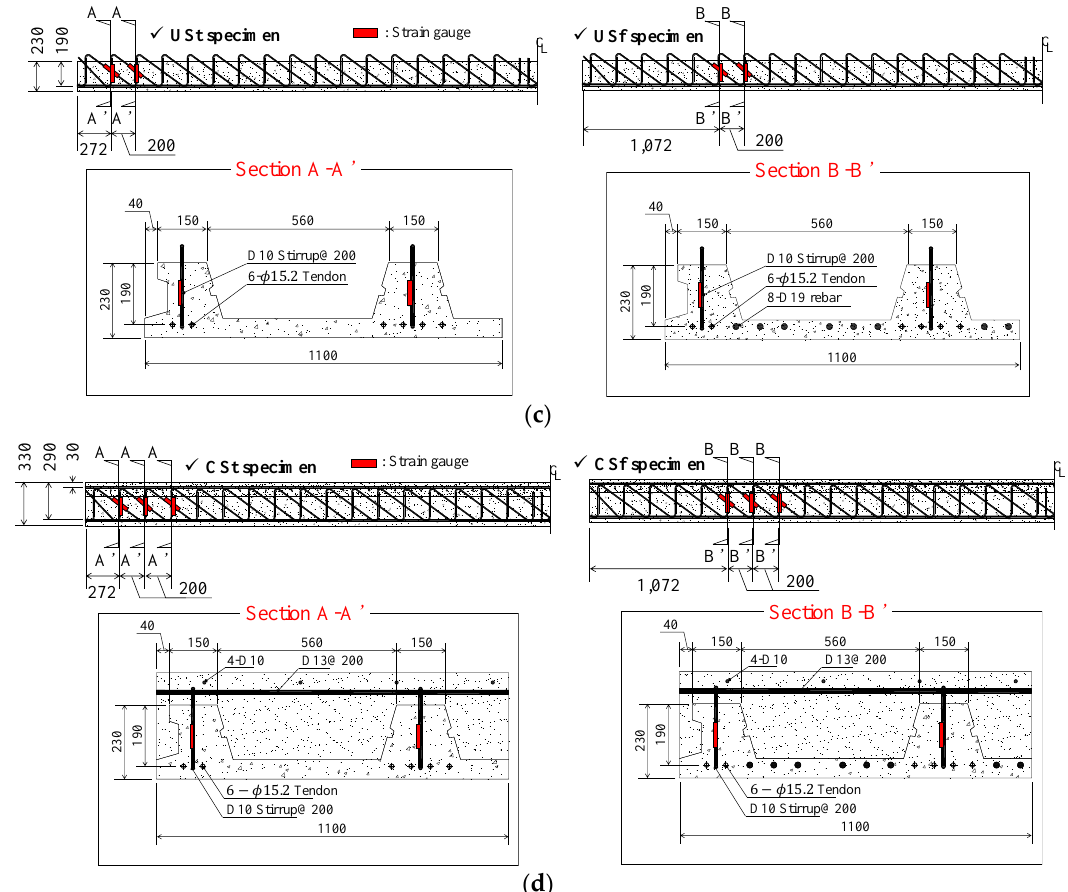
Figure 2. Details of test specimens (unit: mm); ( a ) UF specimen; ( b ) CF specimen; ( c ) USt and USf specimens; ( d ) CSt and CSf specimens.